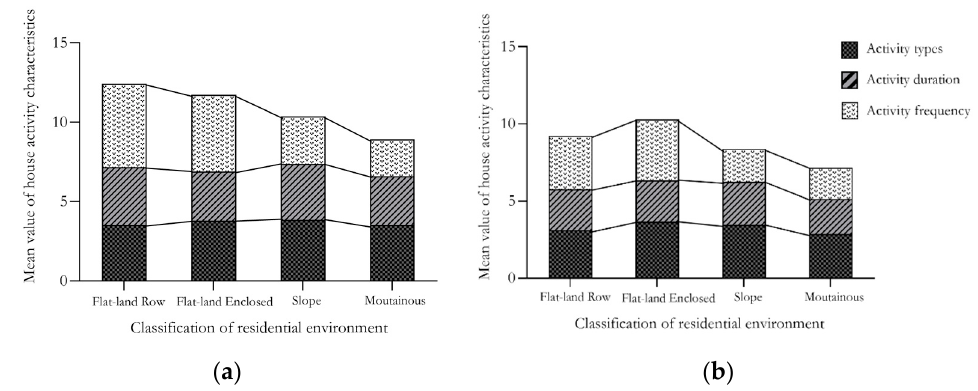
Figure 2. Activity characteristics of elderly people with different emotions. ( a ) positive emotion. ( b ) negative emotion.